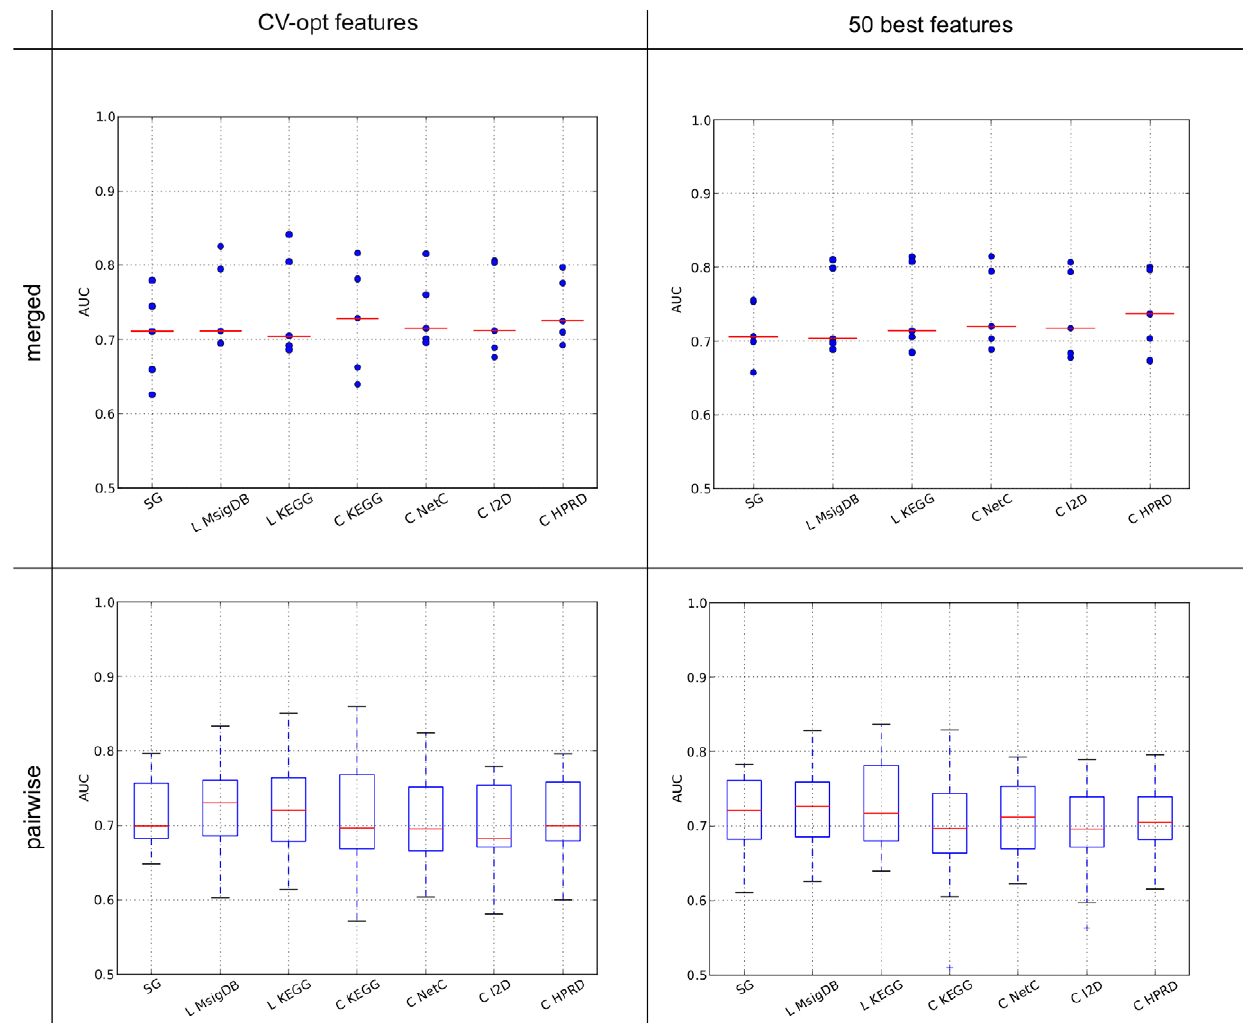
Figure 5. Classification results for merged and paired setting. In the merged setting one Affymetrix data set is set aside as test and the remaining four Affymetrix data sets are merged into a single data set. This is repeated until every one of the five data sets acted as a test set. Top row: Results for the merged setting. The red lines indicate the median. Bottom row: Only the five Affymetrix data sets were used in the paired setting.